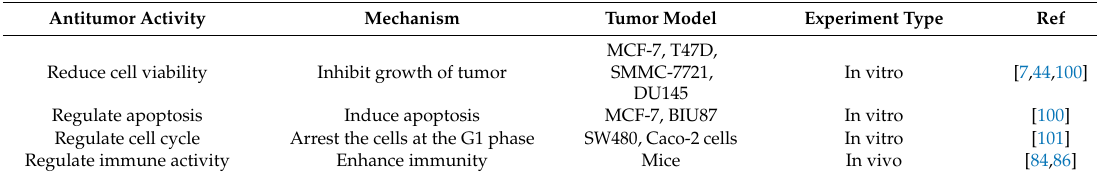
Table 5. Antitumor activities and mechanism of